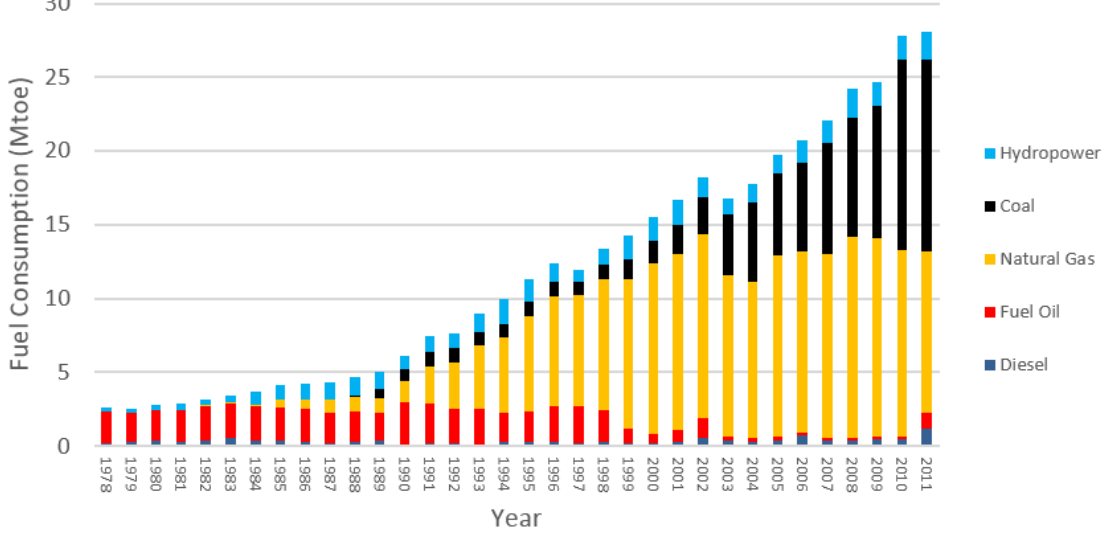
Figure 25. Fuel consumption in electricity generation in